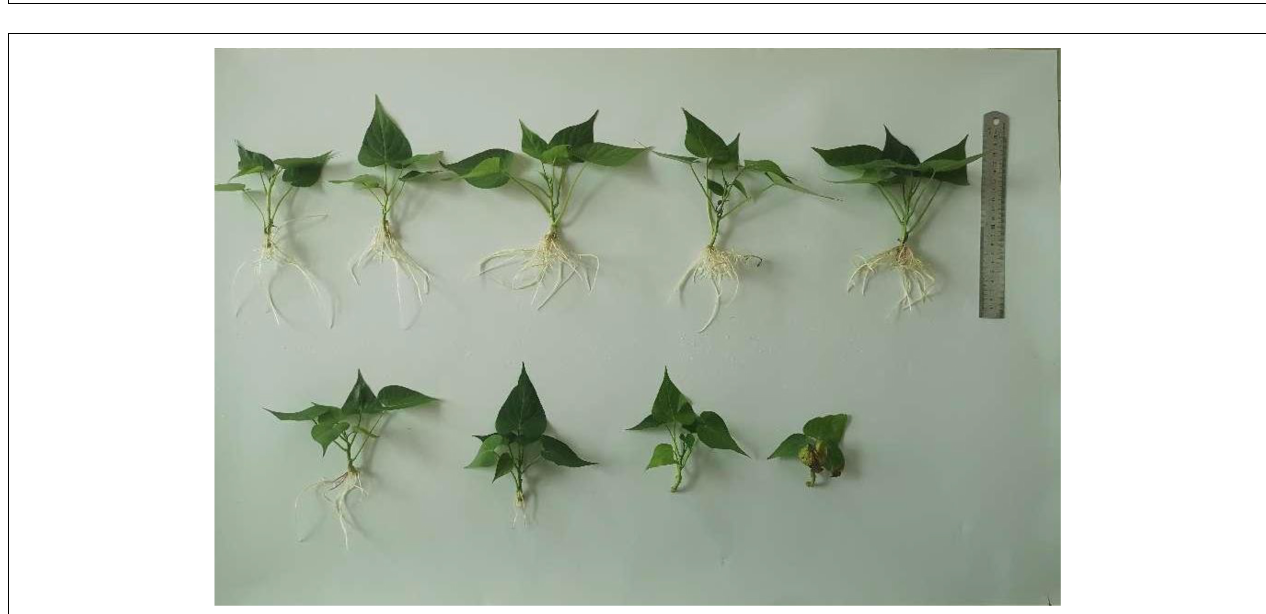
FIGURE 2 | Growth of Shangshu19 under different selenium concentrations. The selenium concentrations in the first row from left to right are 0, 0.2, 0.5, 1, and 3 mg/L, and the selenium concentrations in the second row from left to right are 5, 10, 20, and 40 mg/L.